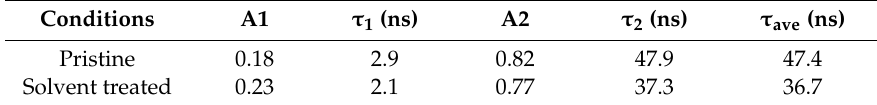
Figure 6. ( a ) Steady-state photoluminescence (PL) and ( b ) TR-PL spectra for perovskite films based on pristine and DMSO solvent washing treated PEDOT:PSS layers. Table 2. Fitted decay times of perovskite films based on pristine and solvent washing treated PEDOT:PSS layers.